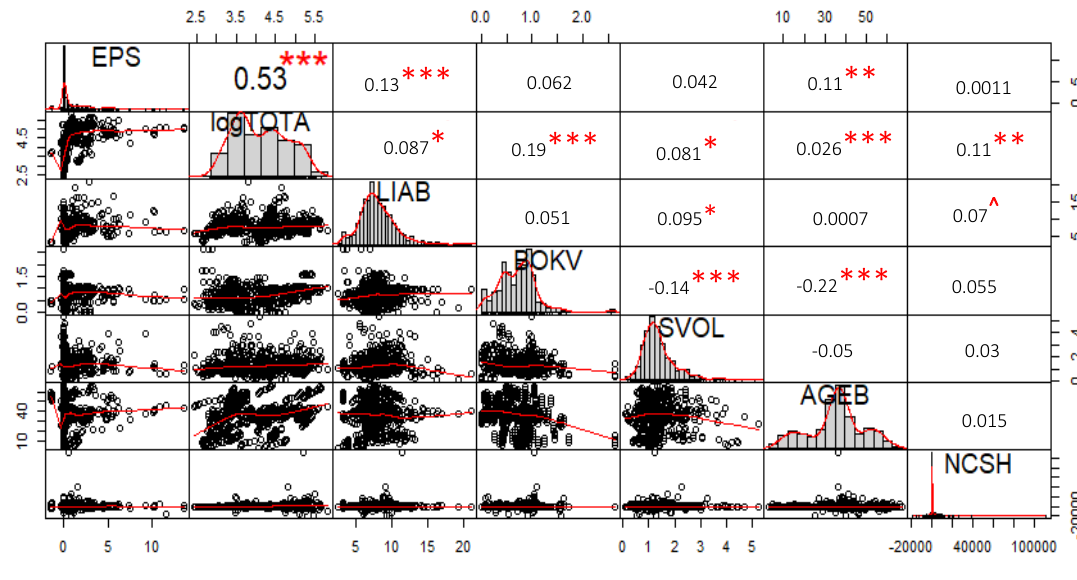
Figure 1. The correlation matrix, histogram, and scatter plots for the study